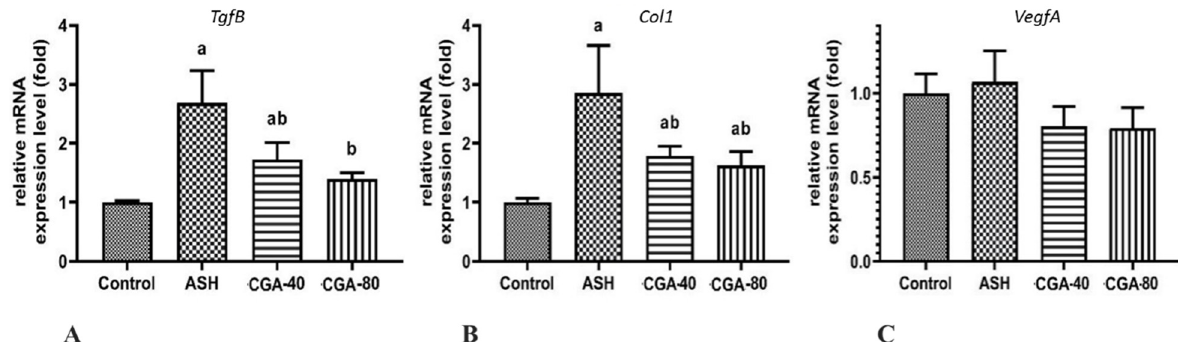
Figure 6. Effect of two CGA doses (40 and 80 mg/kg) on the expression level of genes related to fibrogenesis in the liver of rats with alcoholic steatohepatitis (ASH) induced by chronic alcohol intoxication. ( A )—TgfB; ( B )—Col1; ( C )—VegfA. M ± SD. a— p < 0.05 compared to the control group; b— p < 0.05 compared to the ethanol-administered group.